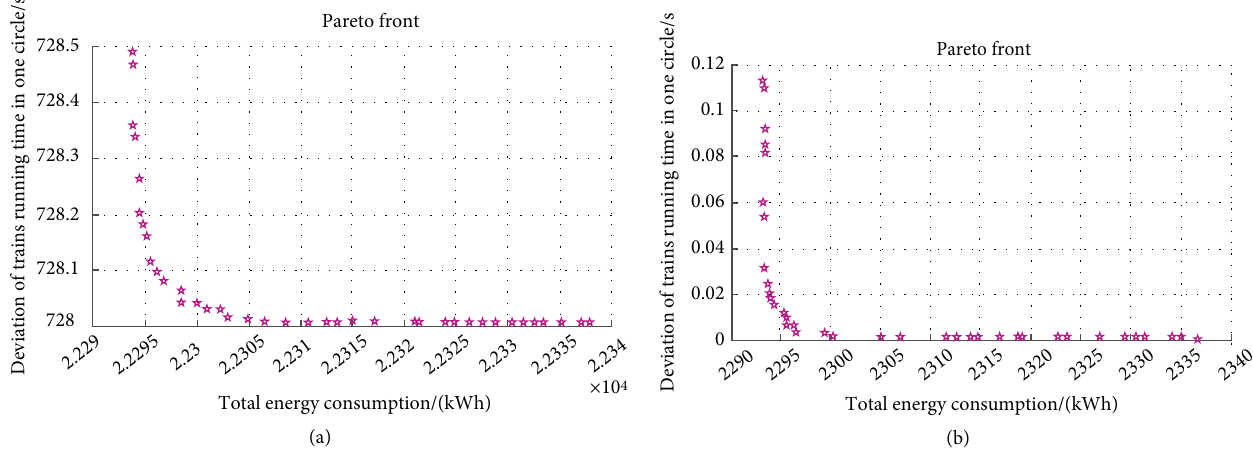
Figure 23: The Pareto front under and OIC = 0.4. (a) The Pareto solutions of the OEST. (b) The Pareto solutions of the OQOST. 𝐺 = 250 Table 13: The values of OEST and OQOST with different main parameters of the algorithm. OEST Generations (G) Optimal individual coefficient (OIC)